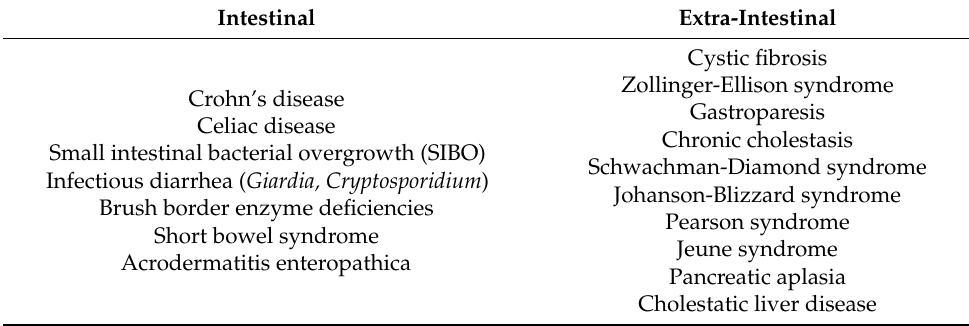
Table 1. Causes of childhood